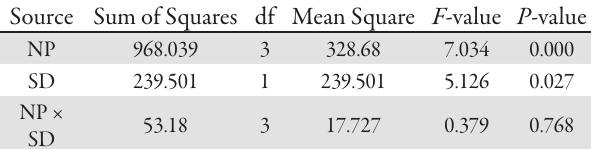
Tab. 2. Analysis of variance (ANOVA) for the effect of number of machine passes (NP) and soil depth (SD) on soil porosity Source Sum of Squares df Mean Square F -value P -value